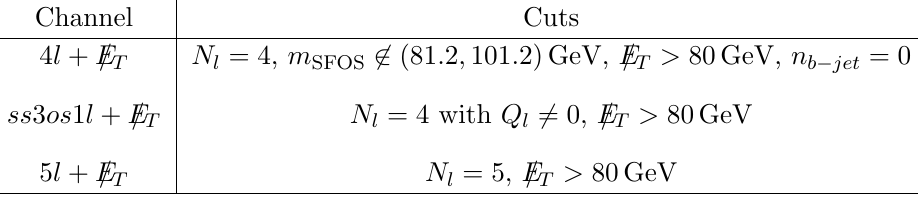
Table 2 . The di(cid:11)erent choices of cuts for each type of multilepton